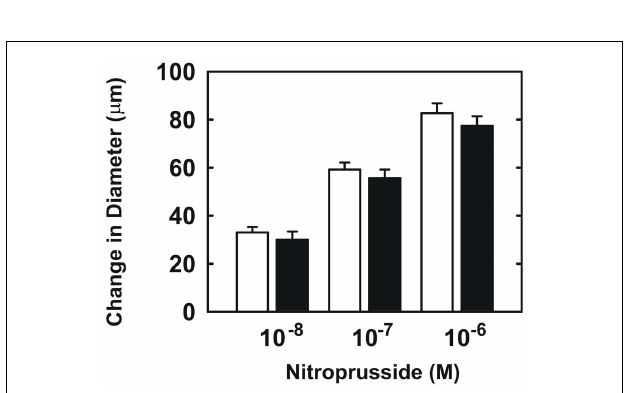
FIGURE 5 | Sodium nitroprusside-mediated increases in internal diameter of gracilis muscle arterioles . Arterioles isolated from control (open symbol) or diabetic (closed symbol) rats were exposed to various concentrations of sodium nitroprusside. Results are expressed as mean ± SEM ( n =